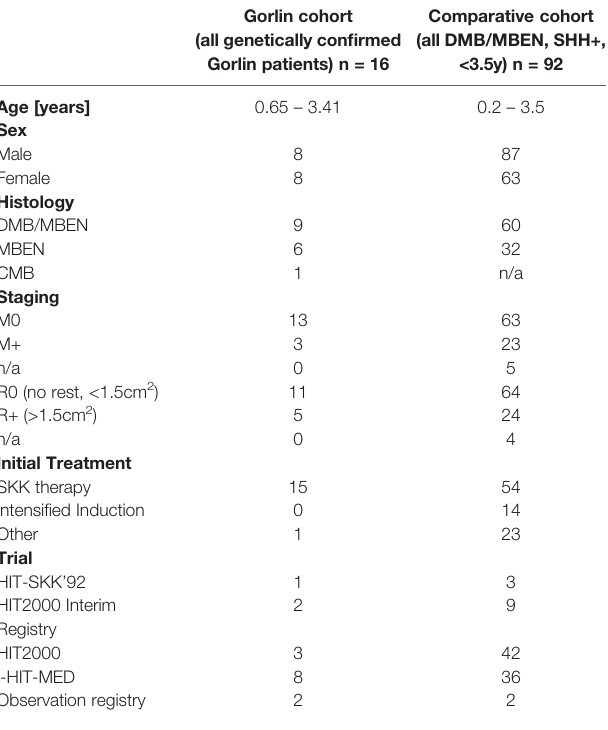
TABLE 1 | Patient characteristics for the Gorlin cohort (all genetically diagnosed PTCH1 and SUFU associated Gorlin syndrome patients) vs. the Comparative cohort (all DMB/MBEN, SHH+, <3.5y).